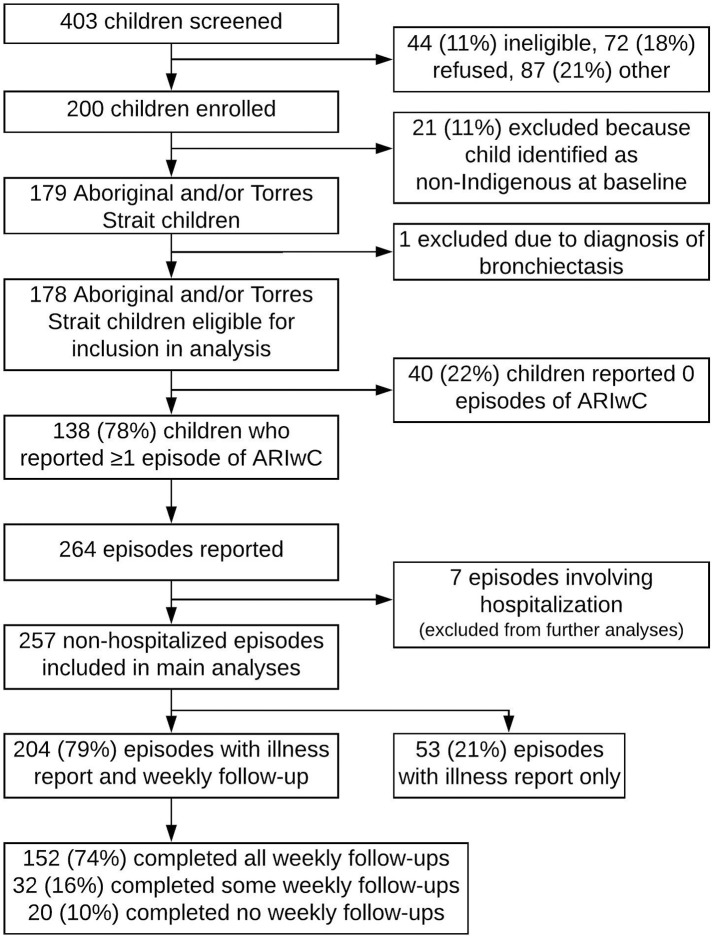
Numbers screened, enrolled, and included in analyses.